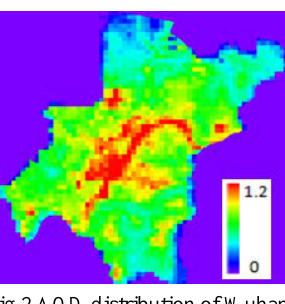
Fig.2 AOD distribution of Wuhan